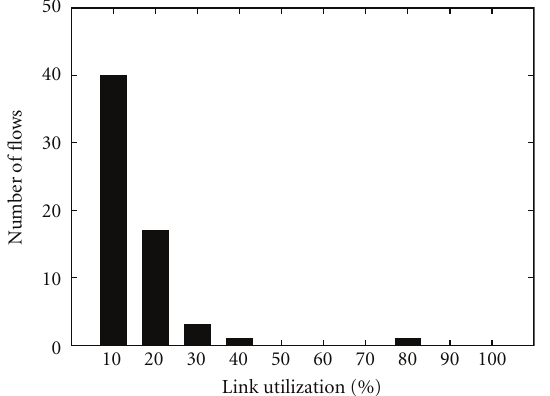
Figure 6: Histogram of link utilization.